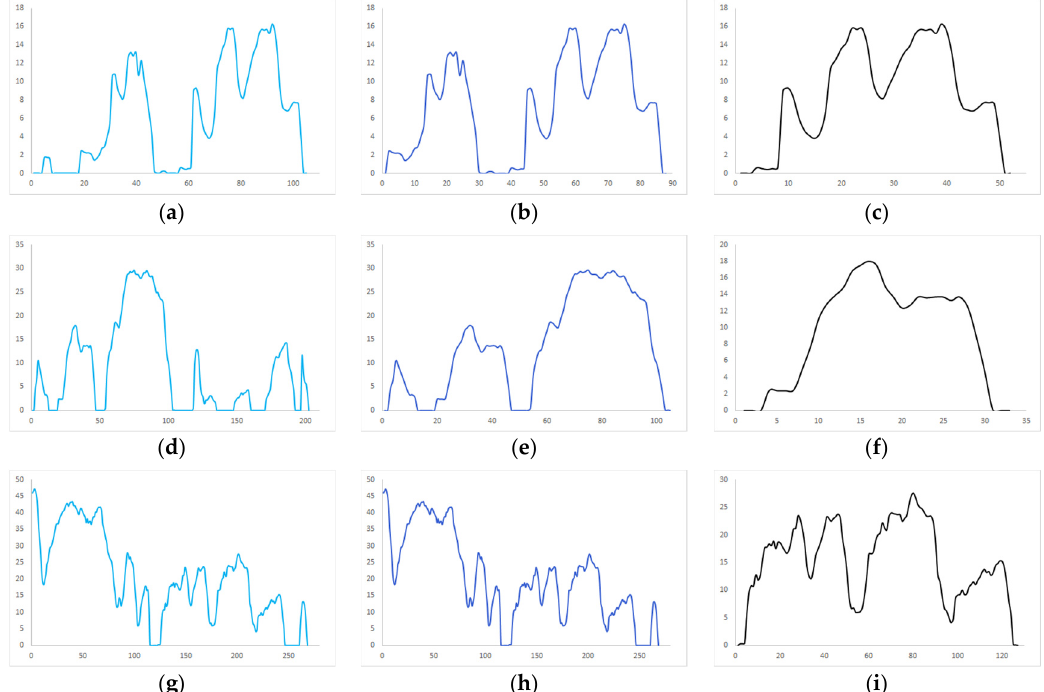
Figure 6. Three cases of dividing kinematic fragments according to different idle durations: ( a ) Car 1 divided into 20s; ( b ) Car 1 divided into 10s; ( c ) Car 1 divided into 5s; ( d ) Car 2 divided into 20s; ( e ) Car 2 divided into 10s; ( f ) Car 2 divided into 5s; ( g ) Car 3 divided into 20s; ( h ) Car 3 divided into 10s; ( i ) Car 3 divided into 5s.